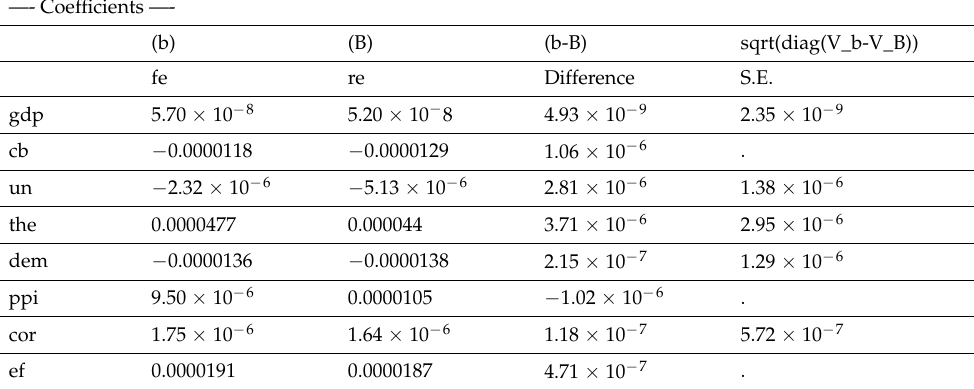
Table A2. Hausman specification test for model